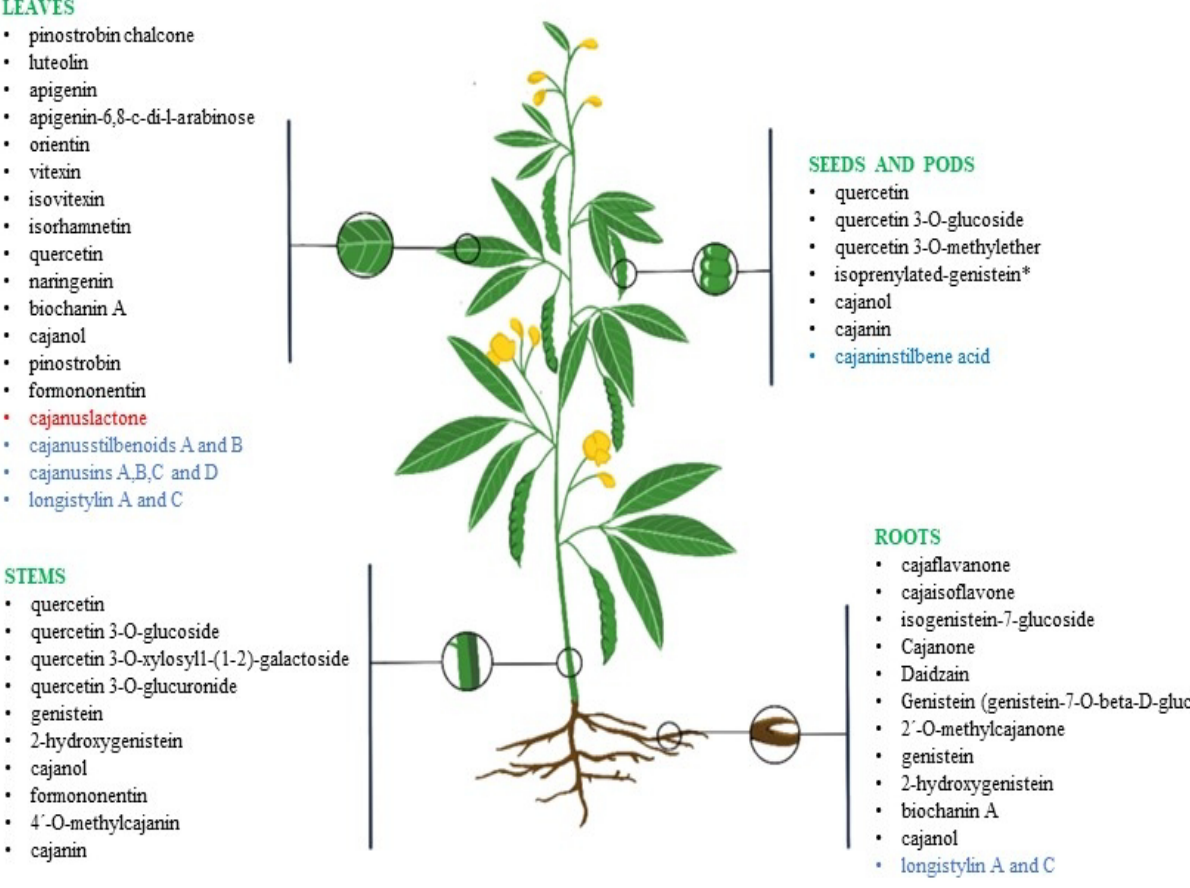
Figure 1. Localization of bioactive components (flavonoids—black, stilbenoids—blue, coumarin— red) in different parts of Cajanus cajan. Note—“*” Isoprenylated-genistein detected in seedlings only.